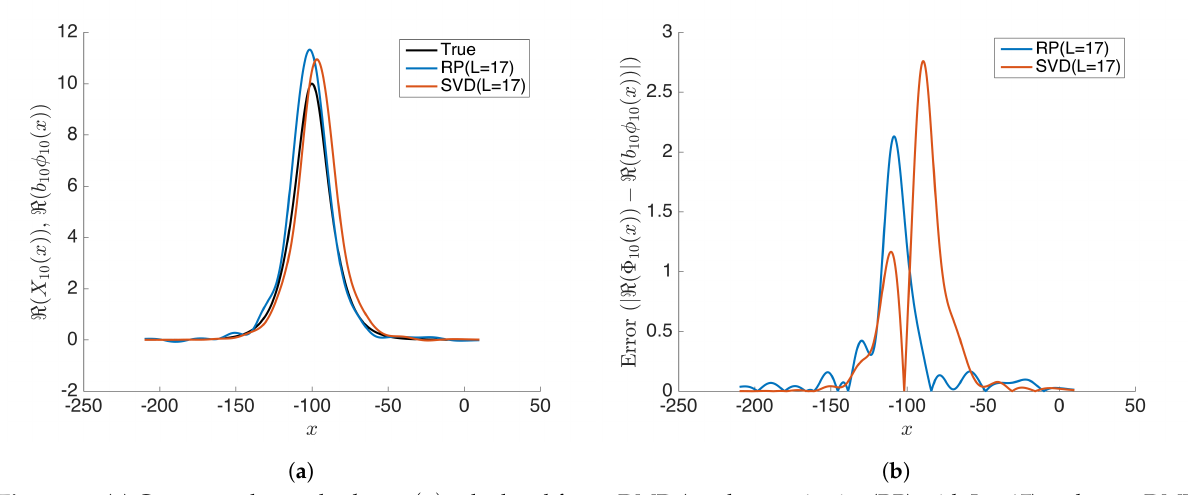
Figure 10. ( a ) Compares the modes b 10 φ 10 ( x ) calculated from rDMD (random projection(RP) with L = 17) and exact DMD (SVD projection with L = 17) methods with the expected true values Φ 10 ( x ) = 10sech ( 0.1 x + 10 ) . ( b ) Shows the absolute error for estimated values from rDMD and exact DMD.